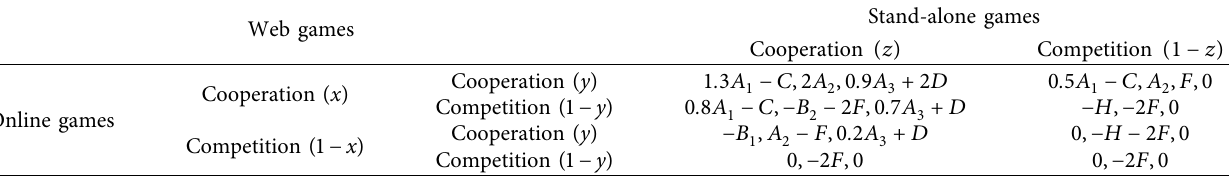
Table 1: Payment matrix under diferent strategy